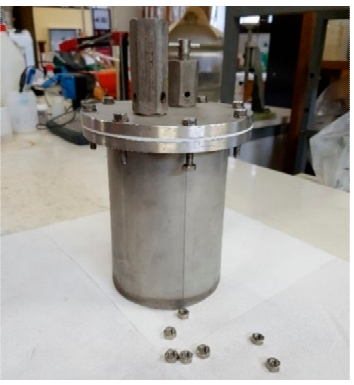
Figure 1. Laboratory autoclave for alkali extraction tests from aggregates.